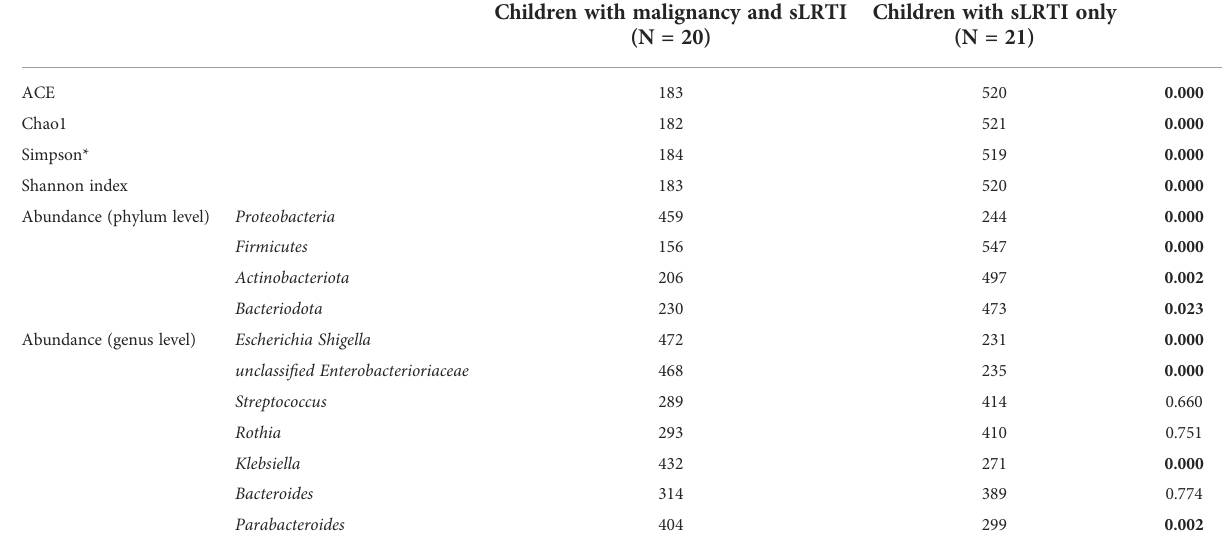
TABLE 3 Comparison of a diversity between LRTI children with/without hematological malignancies. a diversity